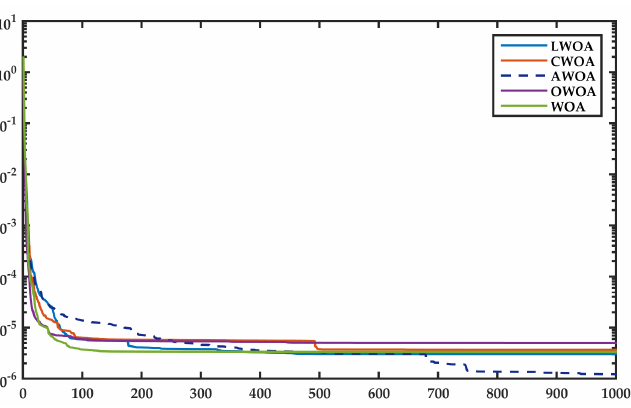
Figure 14. Results of MOR for function 1.